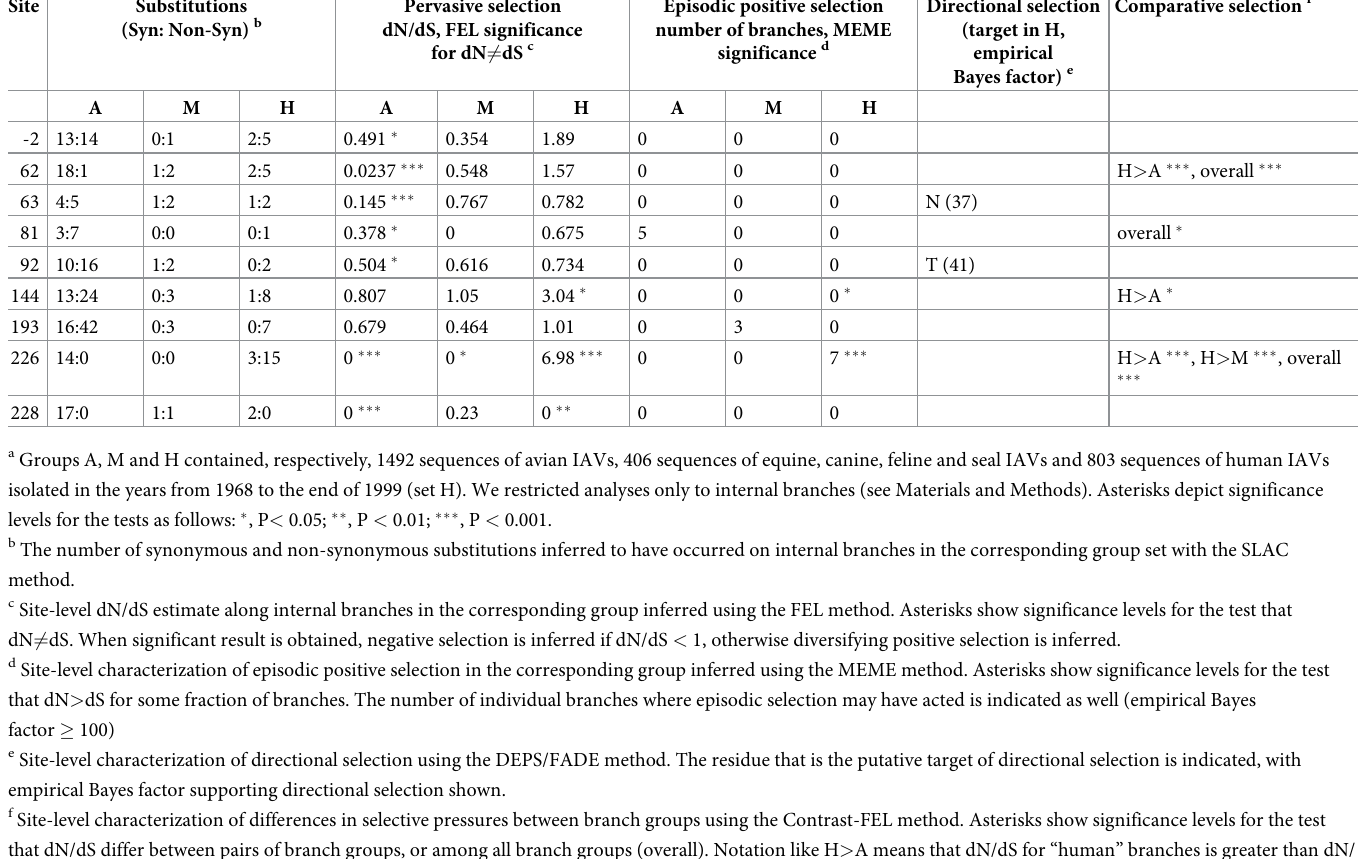
Table 1. Selection pressure analysis of 9 sites of the HA of avian, mammalian and human IAVs a . Site